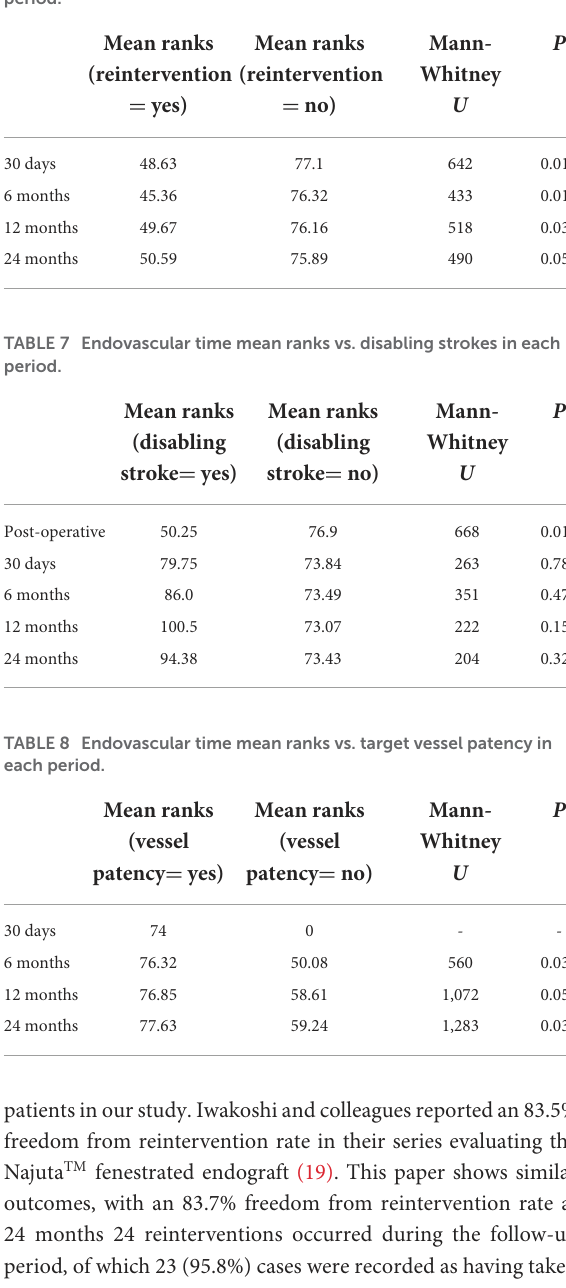
TABLE 9 Geographical distribution of